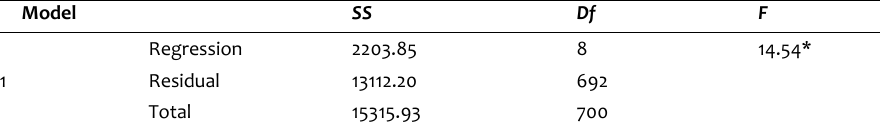
Table 5. ANOVA Table of MLR Analysis